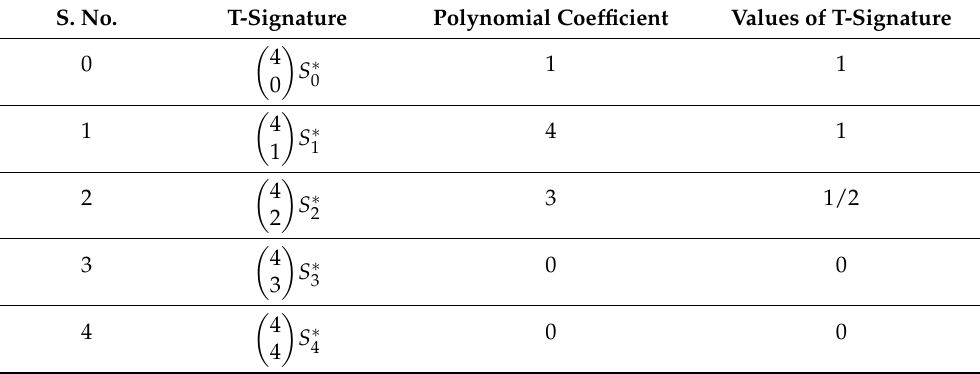
Table 5. The values of tail signature of 2-out-of-4: G system by using binomial formula. S.